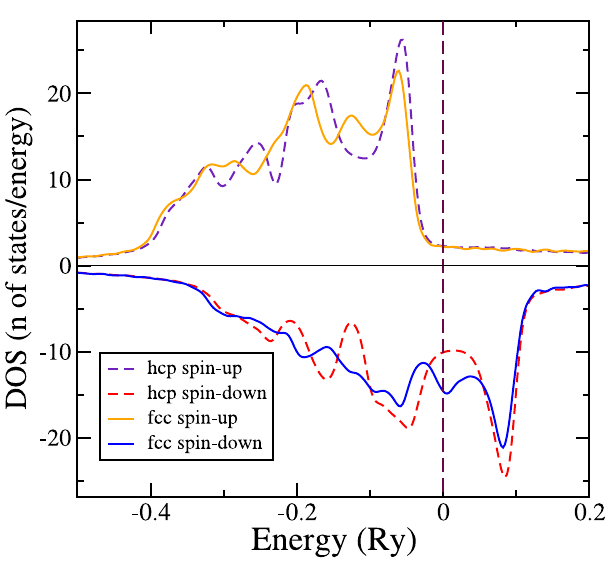
Figure 4. Spin projected density of states for the Co hcp and fcc phases. The Fermi level is indicated by a dashed vertical line at 0